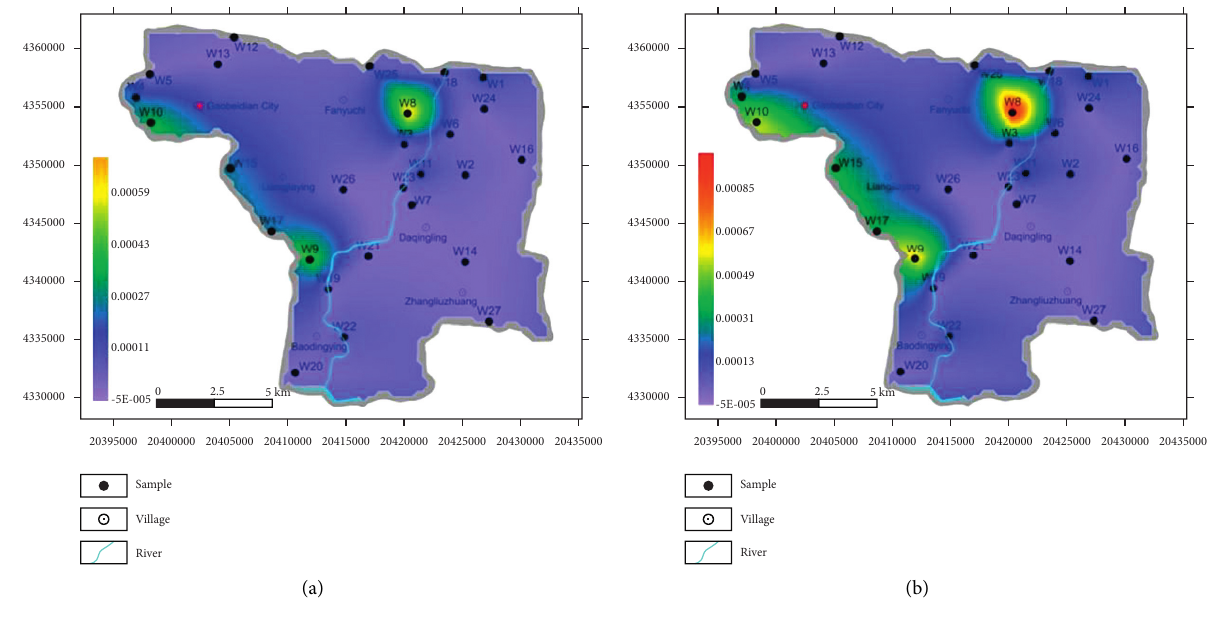
Figure 8: Carcinogenic risk of the groundwater samples for adults and children.